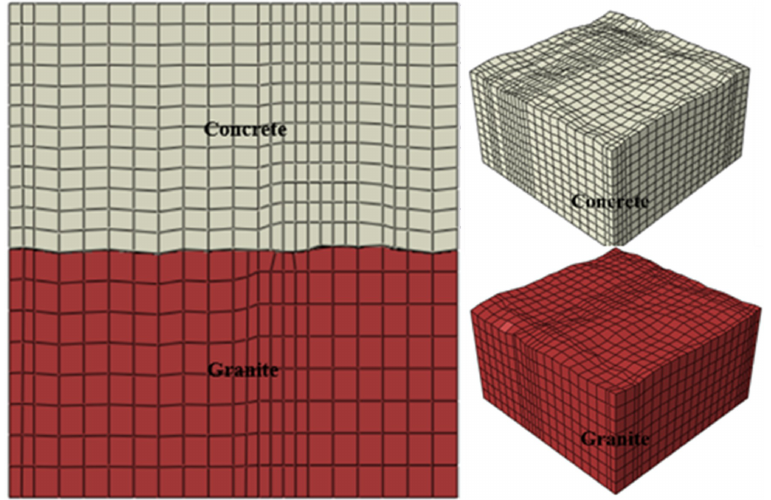
Figure 17. Mesh—rough concrete and granite